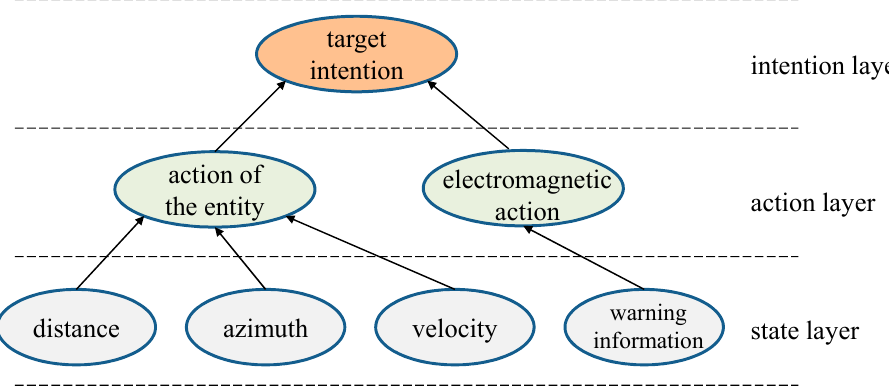
Figure 5. Evidence network structure of target intent recognition.